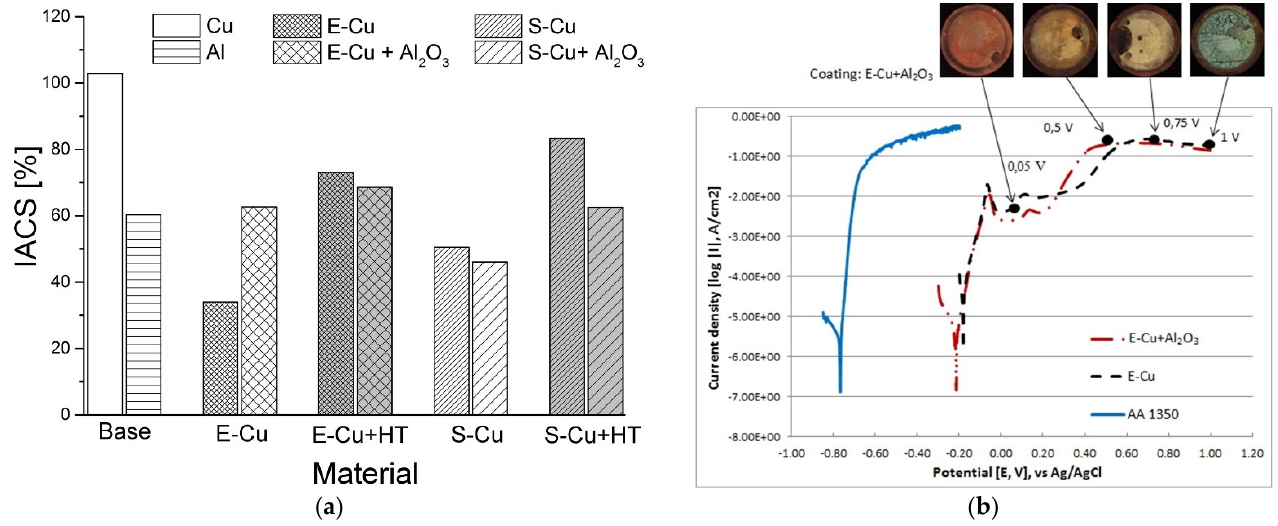
Figure 13. Electrical conductivity ( a ) and polarization behaviour ( b ) of LPCS coatings on AA1350 substrate. Powder designation: E—dendritic, S—spherical, HT—heat treatment of the coating. Reprinted with permission from [62]. Copyright 2017 Elsevier.